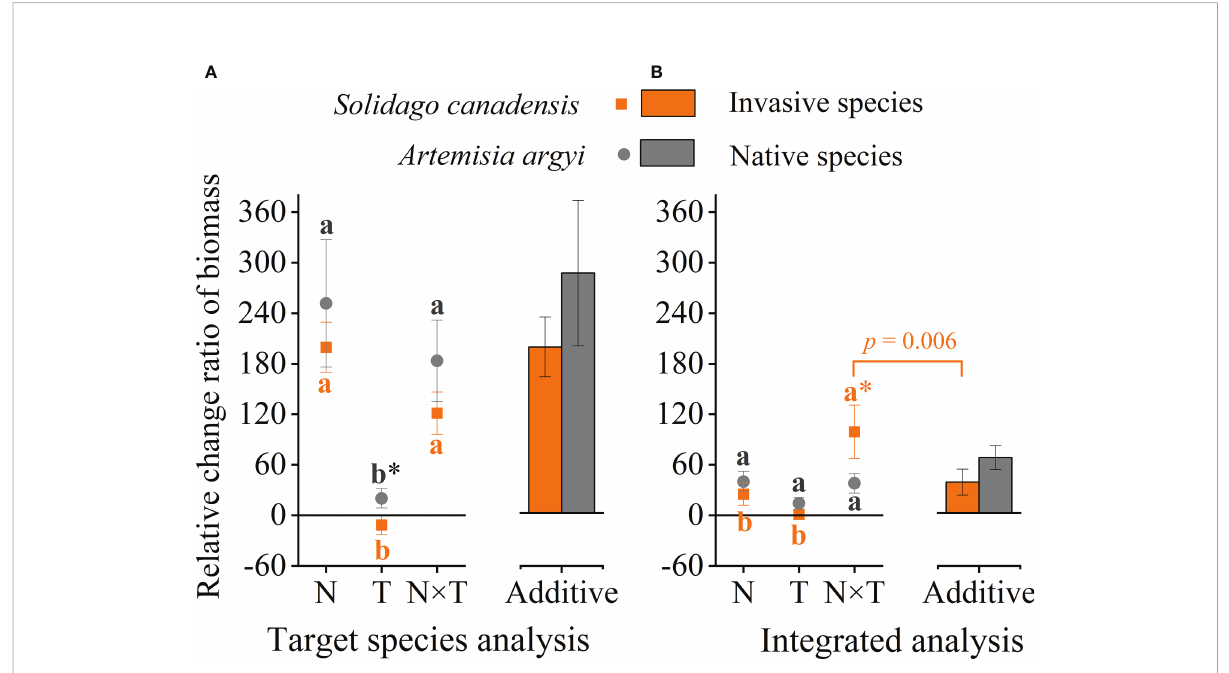
FIGURE 3 Effects of nitrogen addition (N) and warming (T) on the relative change ratio (RCR) of biomass. (A) target species in our experiment: invasive S. canadensis and native A argyi , (B) species in previous studies: invasive species and native species. Values are presented as relative change ratio means ± SE. * indicates the signi fi cance level p < 0.1 between invasive and native species. The additive effect was the sum of the N addition and warming alone effects. Different lowercase letters denote signi fi cant differences among treatments at the p = 0.05